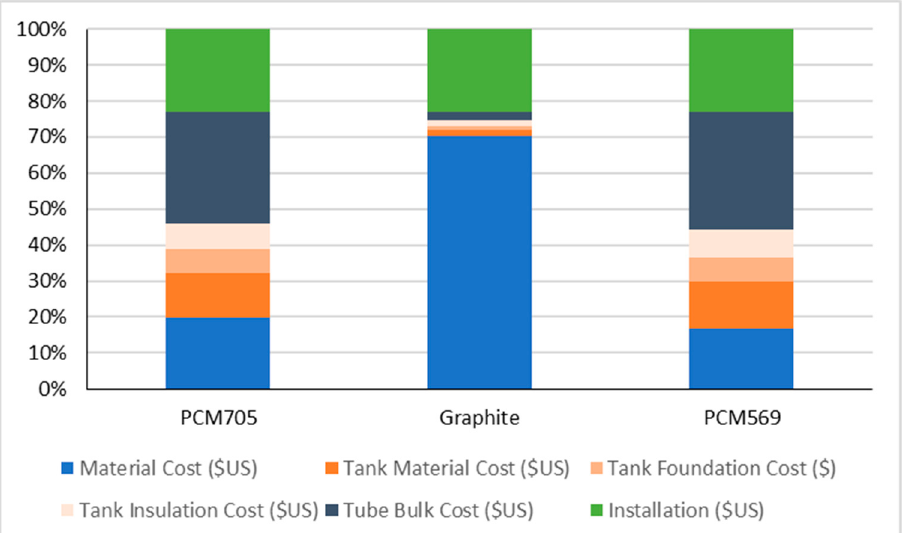
Figure 7. Cost Breakdown of Studied Thermal Storage Systems.